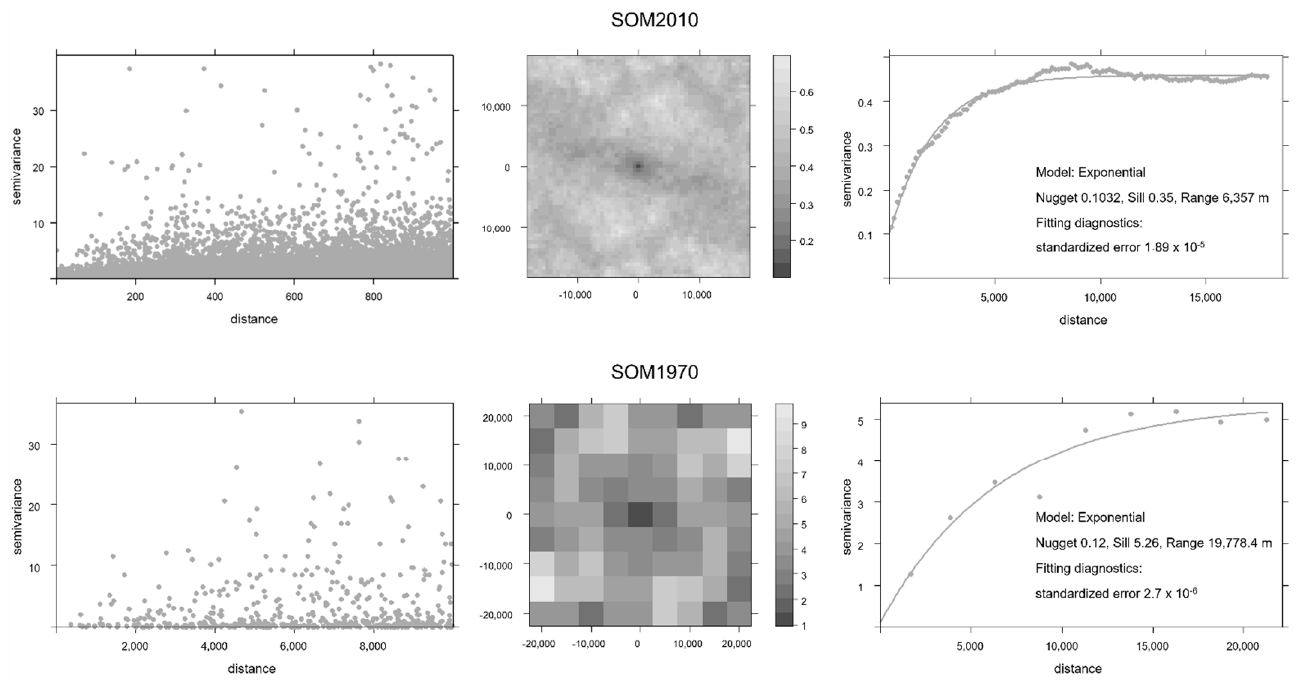
Figure 7. Variogram cloud, variogram map, and best fit of omnidirectional variogram models for SOM 2010 and SOM1970.